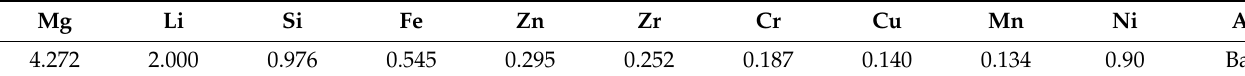
Table 1. Composition of the experimental 1420 Al–Li alloys (wt%).